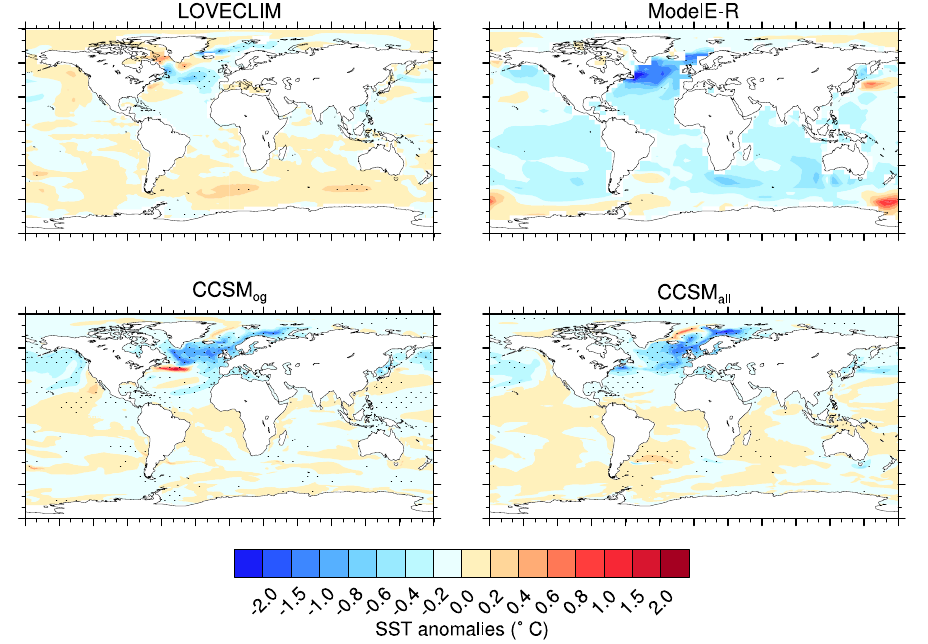
Fig. 5. Anomalies of annual-mean sea surface temperature in the first fifty years following the MWP relative to the control simulation, in degrees Celsius. Stippling shows statistical significance at the 95% level according to a Student’s t test. Statistical tests were not performed for ModelE-R since only decadal averages were